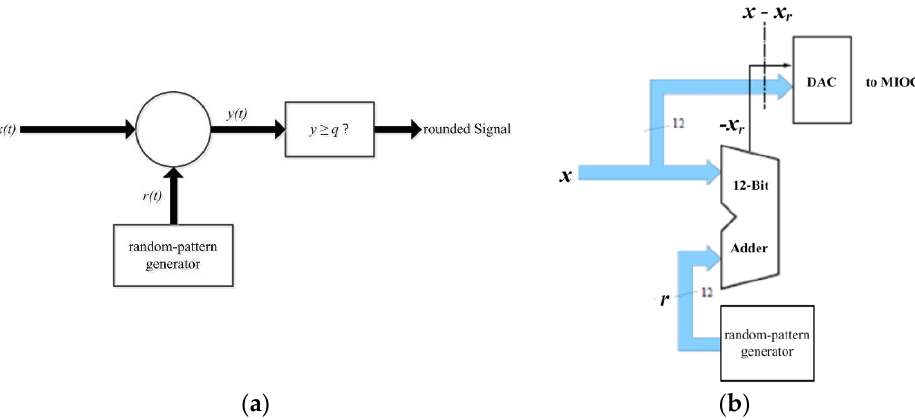
Figure 12 . ( a ) Principle of statistical rounding; ( b ) Resulting optimized circuit realization for driving the MIOC. Sensors 2017 , 17 , 567